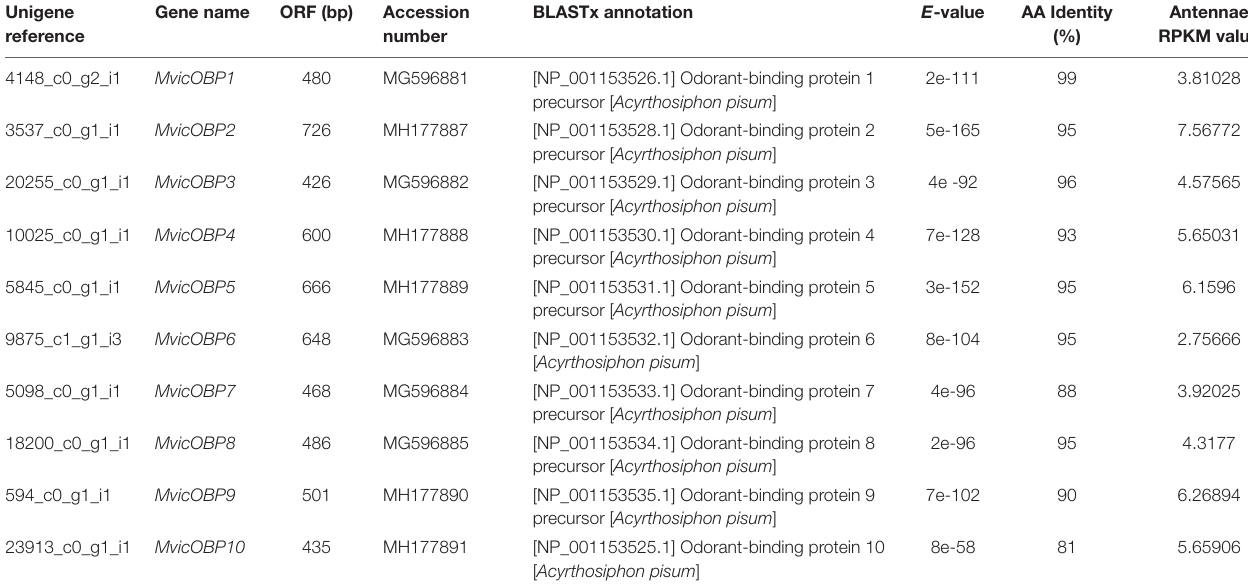
TABLE 2 | Candidate OBP genes in Megoura viciae